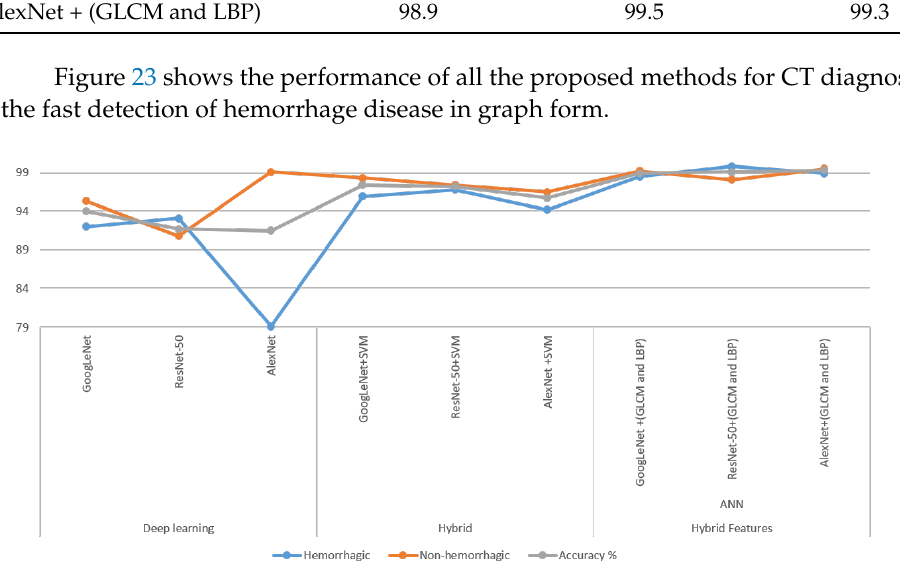
Figure 23. Performance of all proposed methods for fast detection of hemorrhage disease in graph